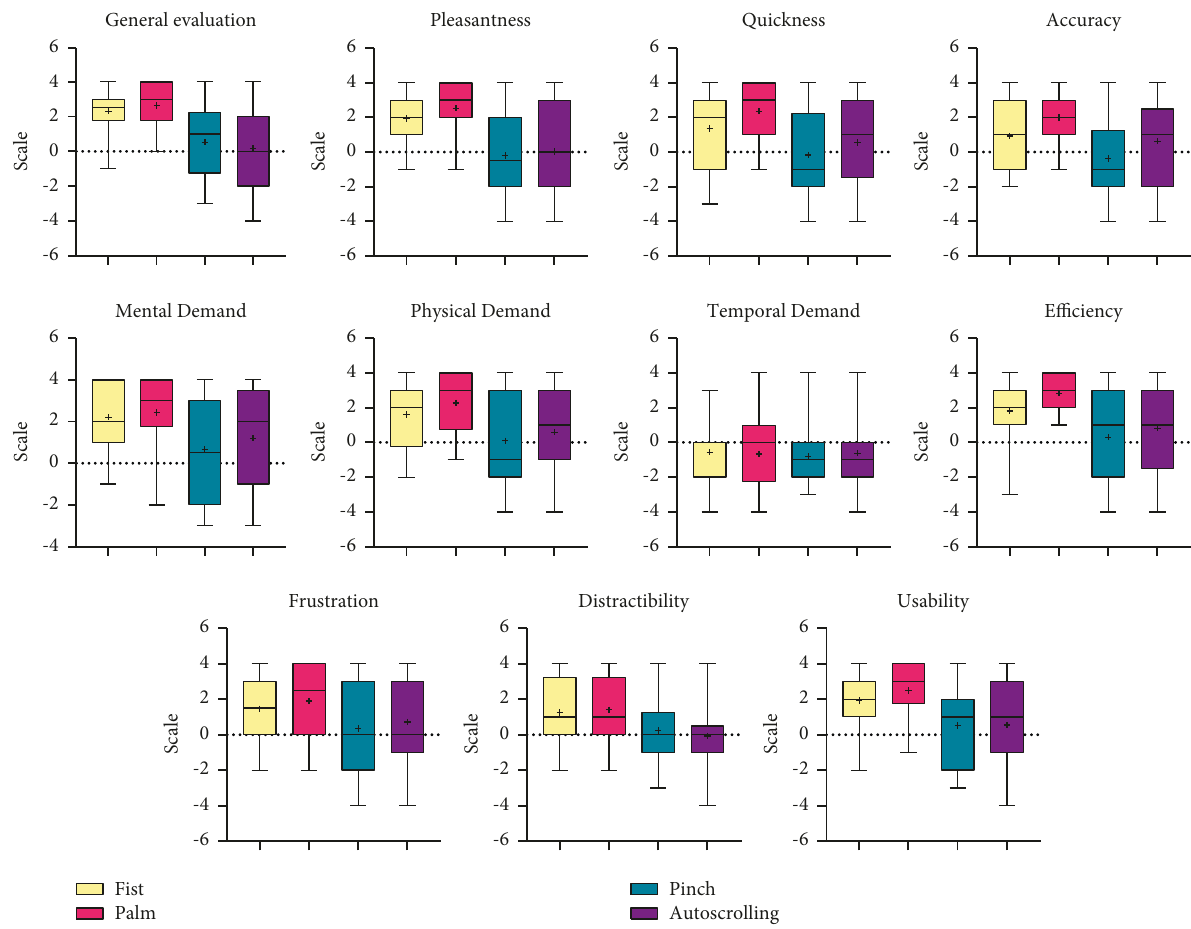
Figure 6: User satisfaction results across different interaction